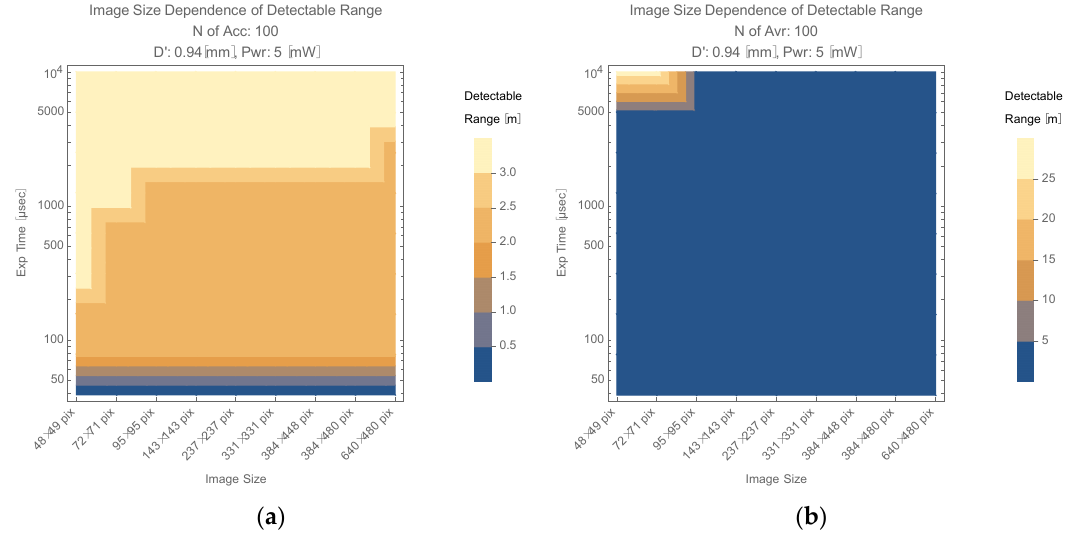
Figure 7. Detectable range plot: ( a ) 100 accumulation; ( b ) 100 averaging.